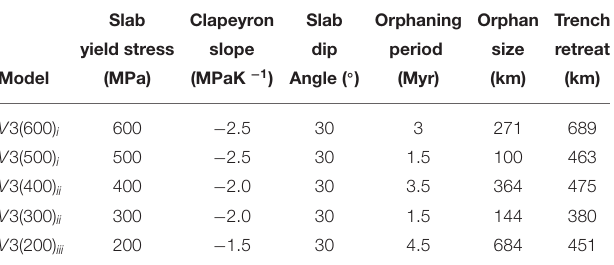
TABLE 3 | Orphan sizes, orphaning periods, and their associated trench retreats compared across orphan variants with different slab yield stresses and Clapeyron slopes for ocean-ocean convergence